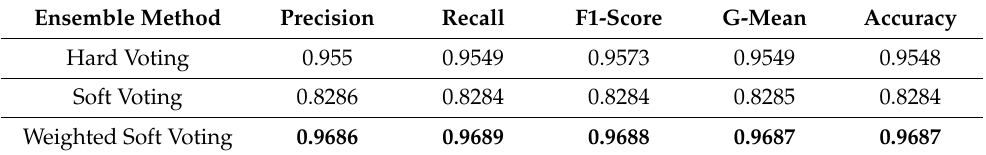
Table 4. Performance of the Voting Ensemble Techniques based on Dynamic Model Weight.